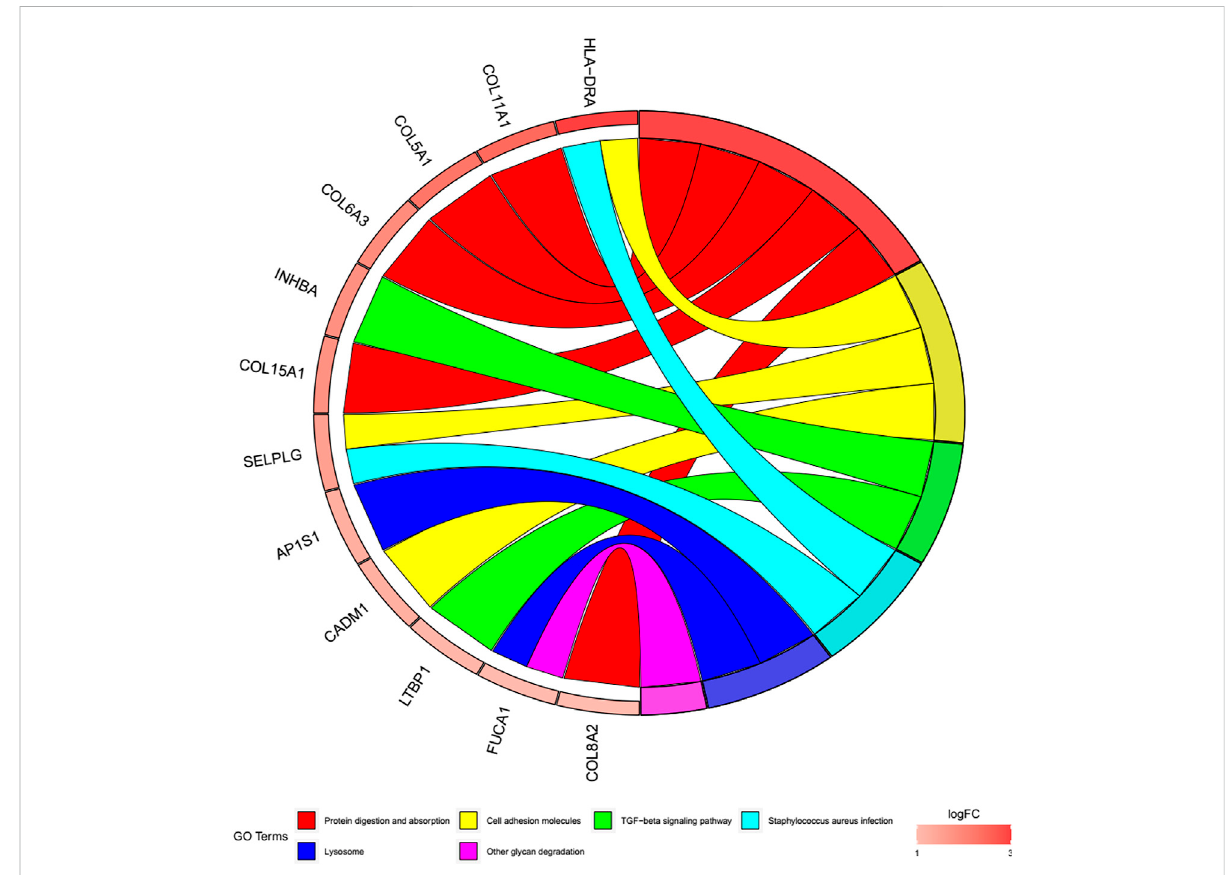
FIGURE 5 Cohort plot of KEGG pathways analysis shows that twelve genes are associated with six KEGG